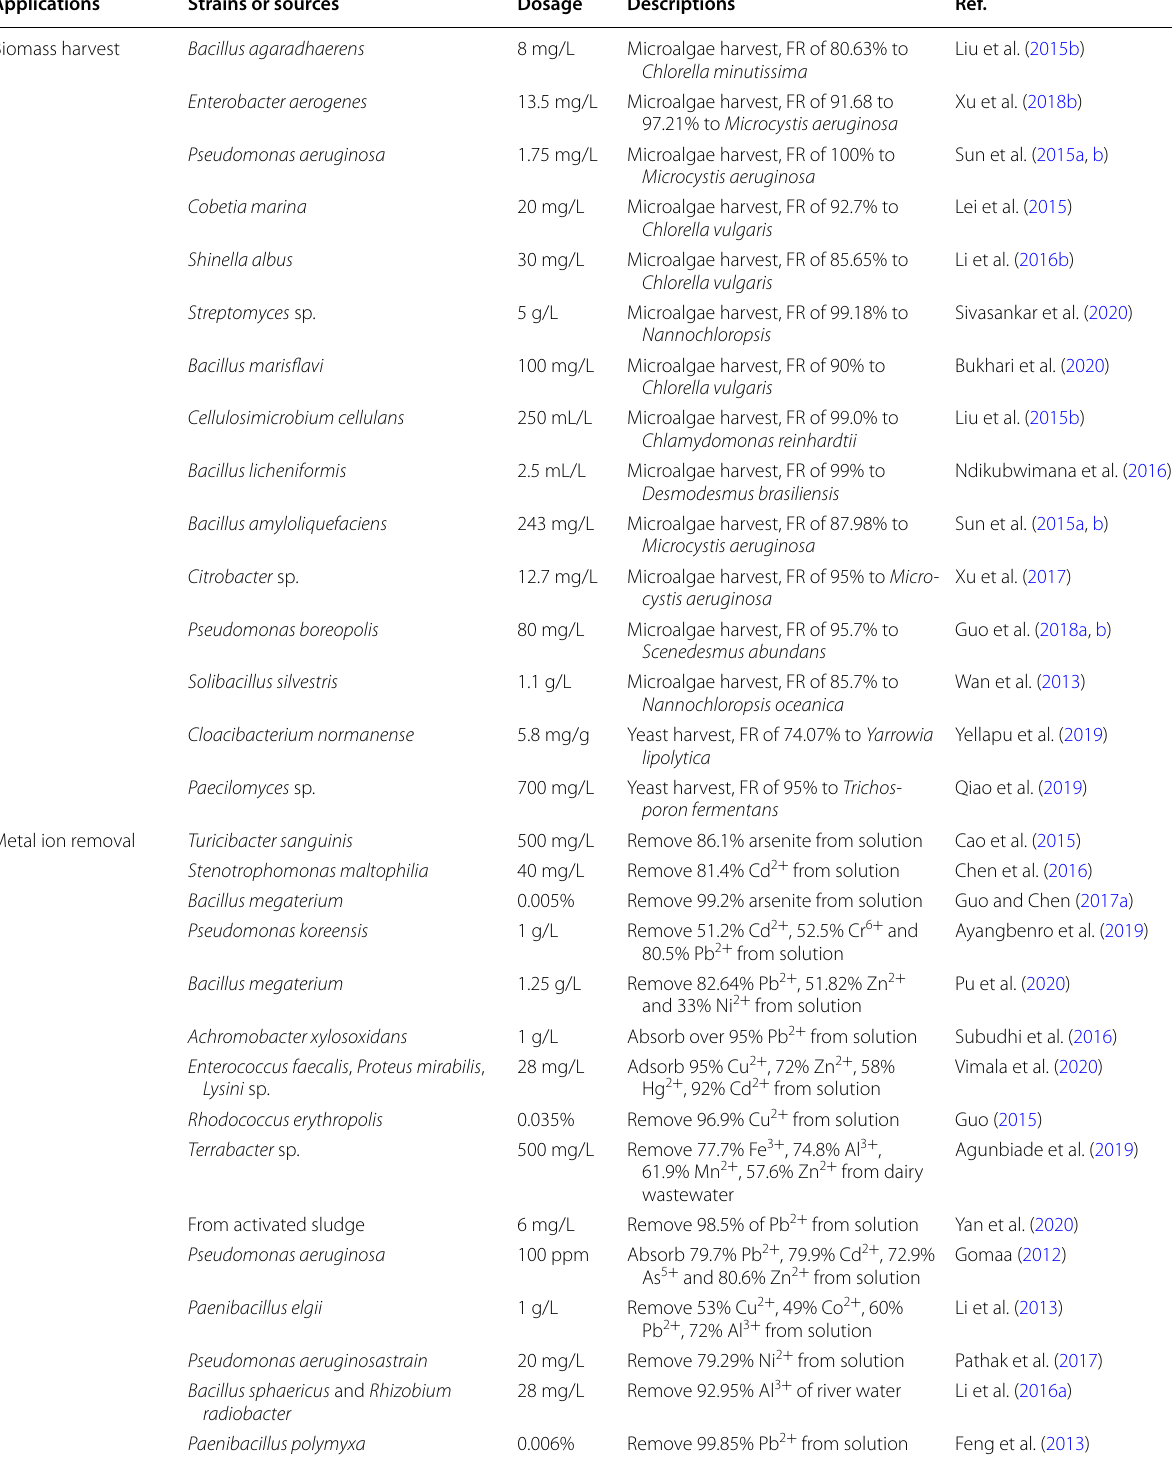
Table 1 Application fields of microbial flocculants